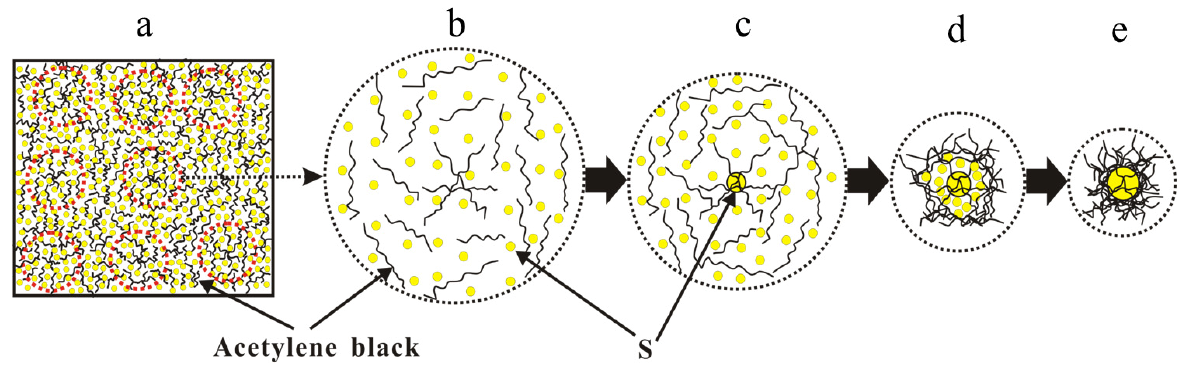
Figure 5. The nucleation and crystal growth schematic diagram of S containing AB at a low solvent evaporation rate and AB concentration process. ( a ) and ( b ) nucleation site; ( c ) nucleation; ( d ) and ( e ) grain growth and AB concentration